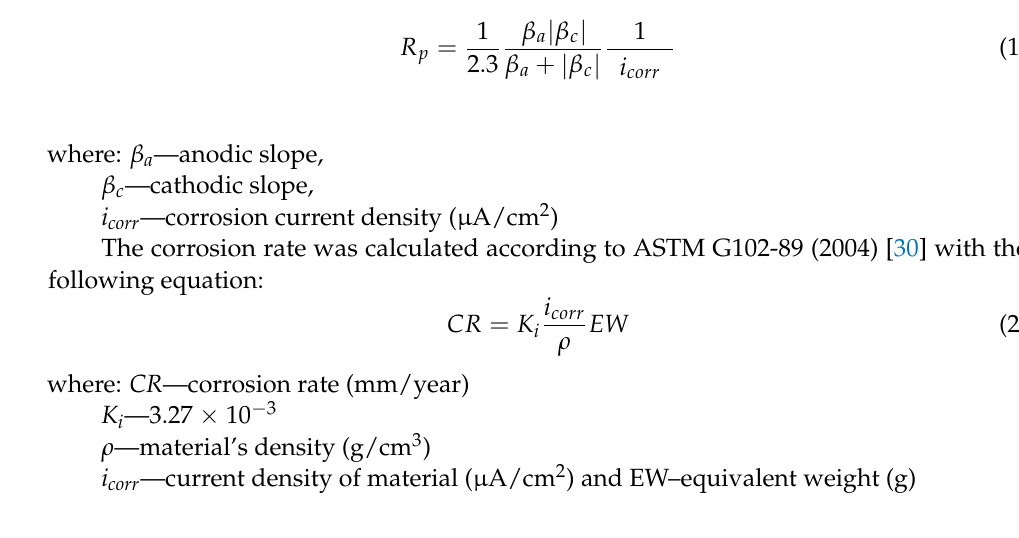
at room temperature with 3.5 wt.%